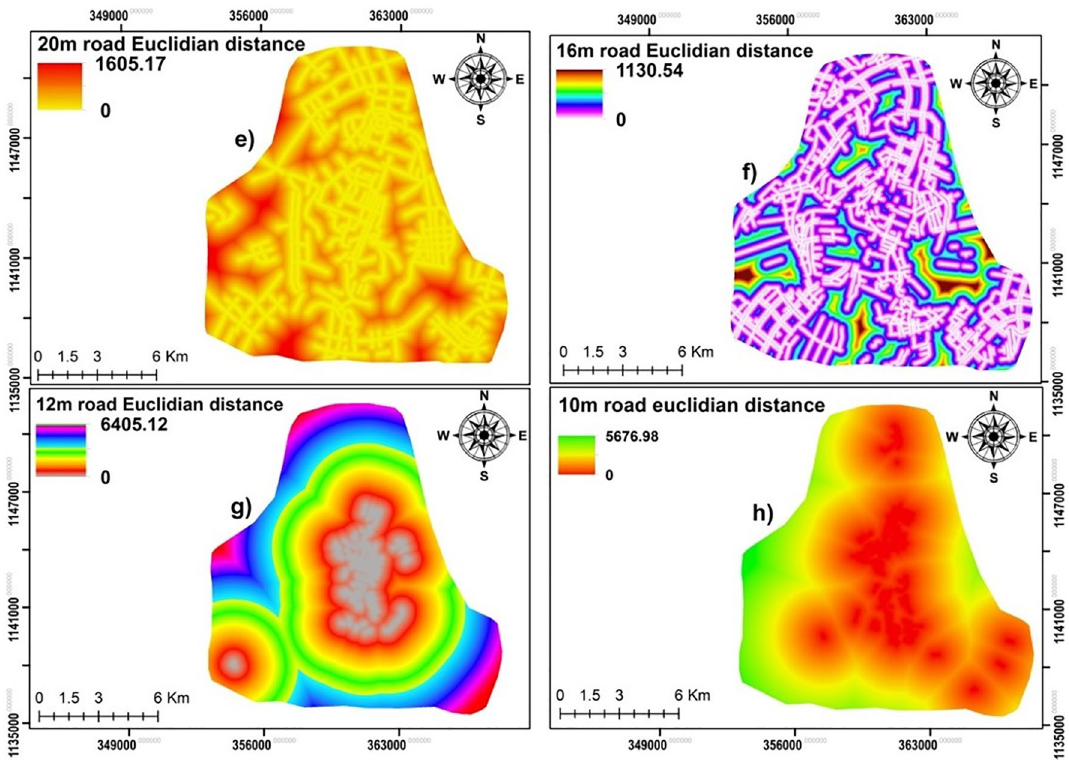
Fig. 4 Proximity to road maps e 20 m f 16 m g 12 m h 10